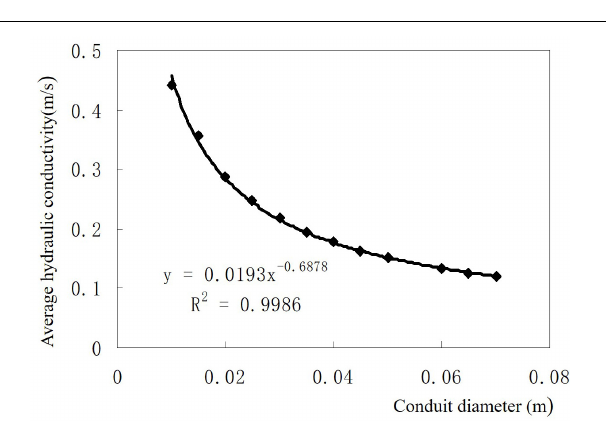
Table 6 . Moreover, the average hydraulic conductivity also decreased with the increase of conduit diameter. The relationship